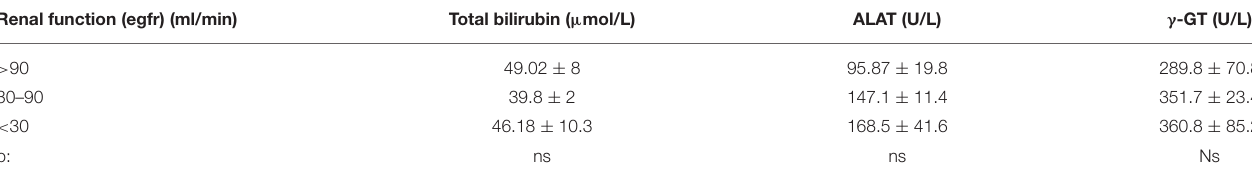
TABLE 5 | Association between liver- and renal function. Renal function (egfr)